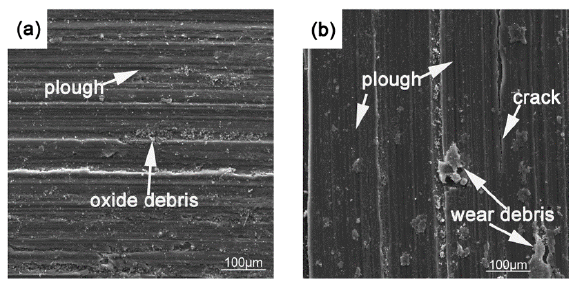
Fig. 4 Wear surface morphology of specimens heat-treated with different